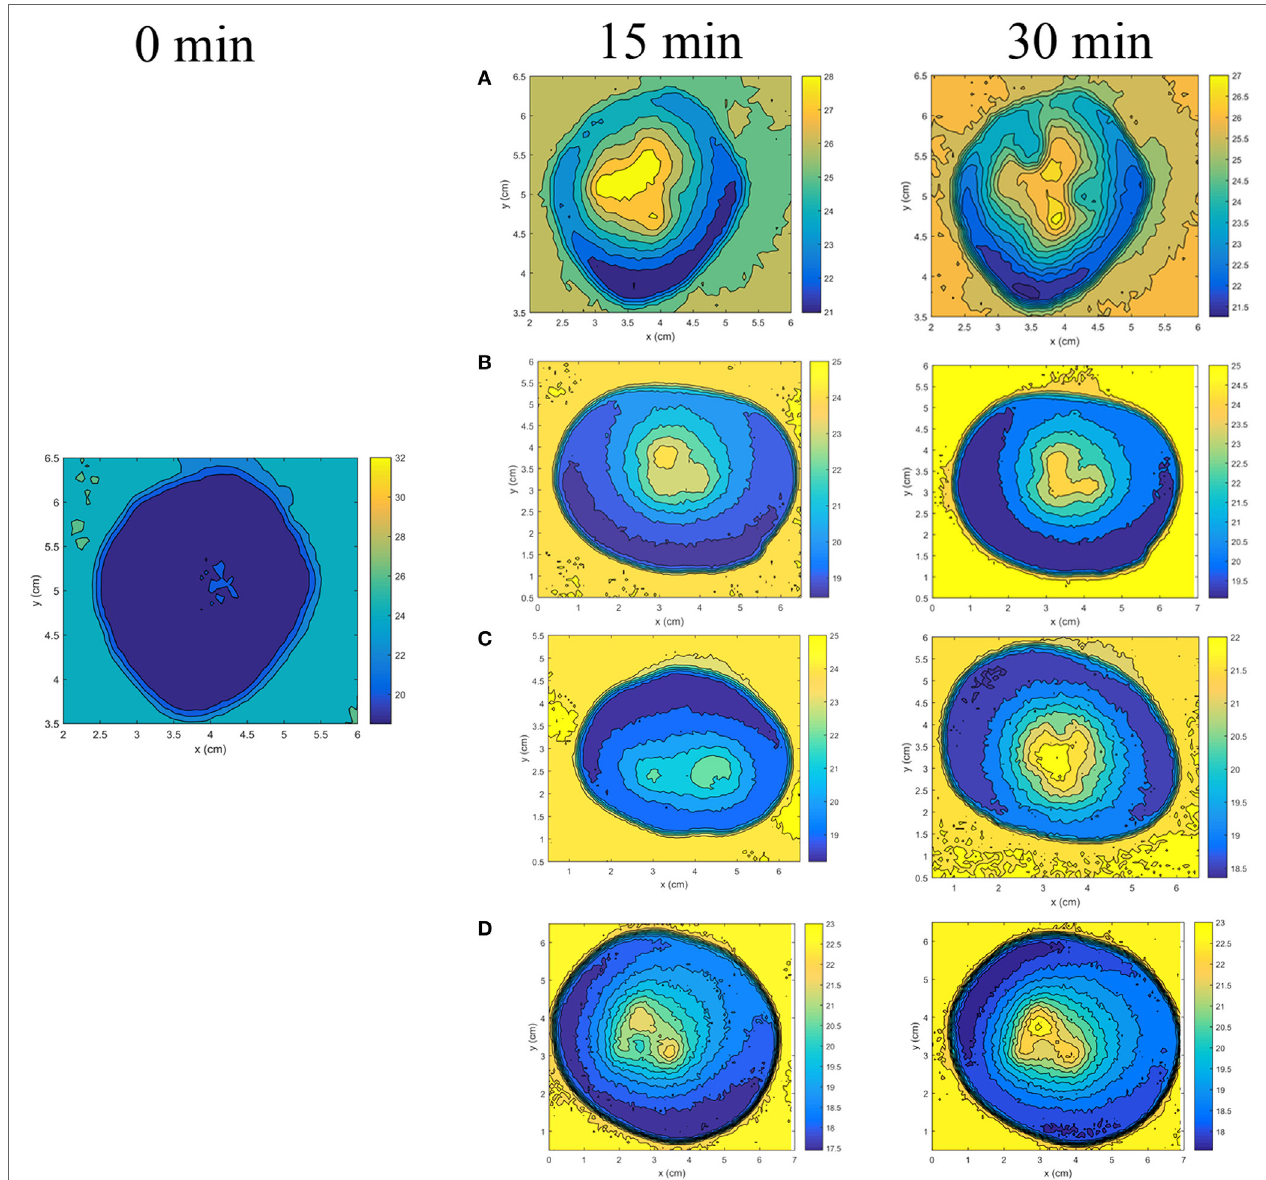
FigUre 4 | Two-dimensional temperature spatial distribution induced in the potato piece at 0, 15, and 30 min of electrochemical therapy exposure for the electrode arrays with (a) circular; (B) elliptical; (c) parabolic; and (D) hyperbolic shapes. The temperature pattern shown at 0 min is similar to that observed in positive control group and negative control group at 15 and 30 min of